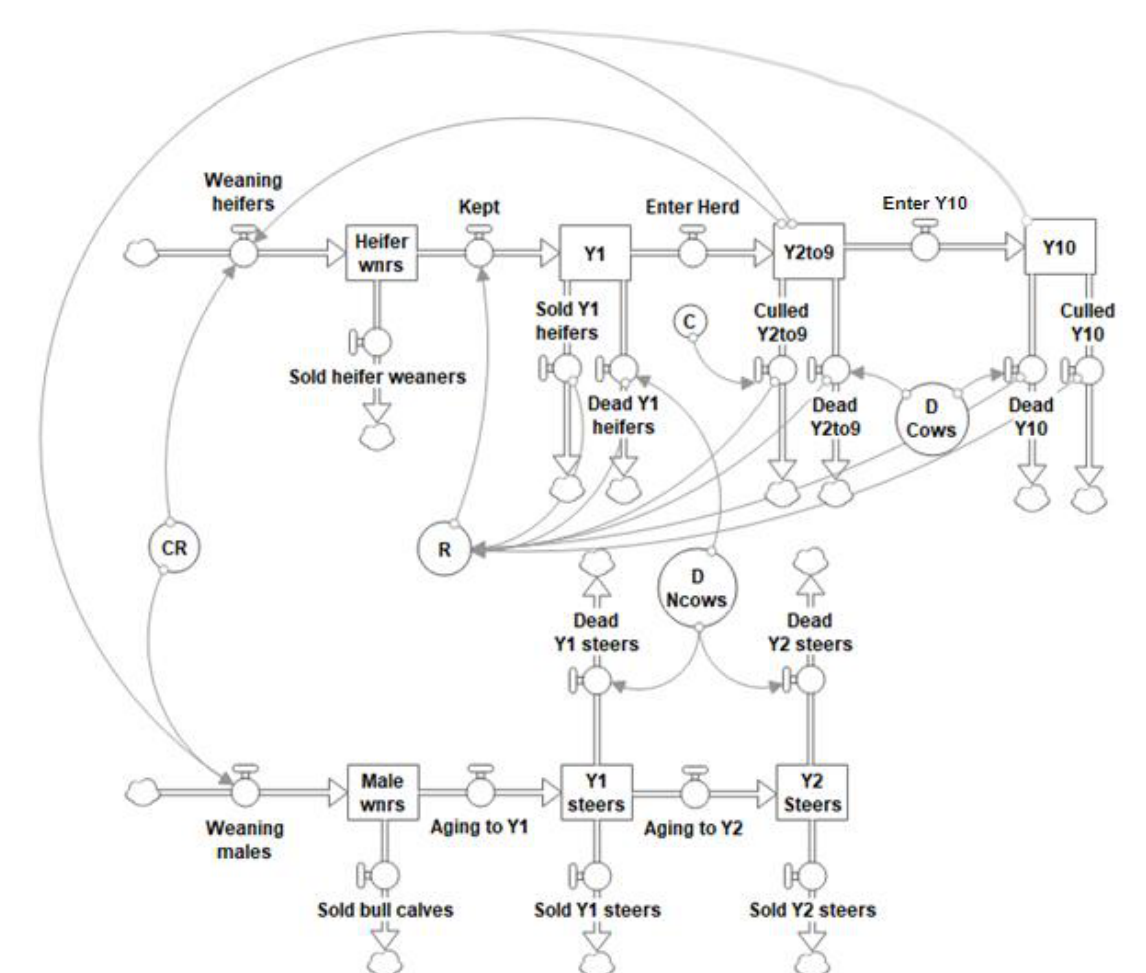
Figure 2. Simplified diagram of the beef dynamics module with cattle in various stock classes and their entering and leaving the herd. The number of weaned calves (heifer and male wnrs) was the product of calving rate ( CR ) and cows ( Y 1 to 10 ). Required replacement heifer calves ( R ) were the sum of all dead, sold, and culled one to ten-year-old heifers and cows. Numbers of dead cows ( Y 2 to 10 ) were determined by their death rate ( D cows ) and numbers of dead heifers and steers were determined by their death rate ( D Ncows ). Numbers of culled Y 2 to 9 cows were determined by their culling rate ( C ) and all Y 10 cows were culled after weaning a calf.